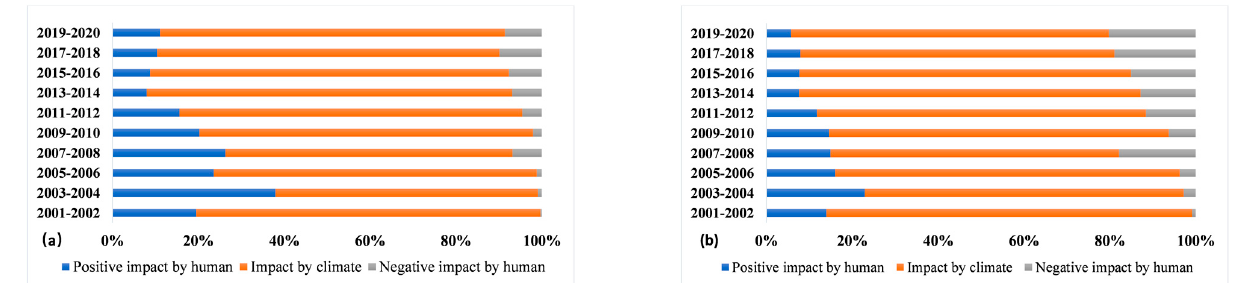
Figure 7. Area percentage of different dominant factors in ( a ) karst areas and ( b ) non-karst areas. Based on the dominant factor analysis, the downside of human activities still outweighed the positive influence on natural vegetation. High-intensity human activities, mainly the unrestrained utilization of land resources, have increased the pressure on vulnerable karst landscapes in the whole basin. Figure 8 shows four cases in karst area, reflecting the damage to natural vegetation caused by diversified human production activities. As illustrated in case(A) and case(B) of Figure 8, the destruction of forests and fragmentation of landscapes were direct consequences of quarry operations, and the NDVI curve manifestations of mining activities sharply decreased; moreover, these mining activities also had negative impacts on regional ecology, such as degradation of ecosystems, deterioration of water quality and biodiversity loss [56–58]. Case(C) shows a large area of artificially grown Eucalyptus. This kind of fast-growing tree has been widely planted in basins with short rotation lengths and strong adaptability, posing a threat to autochthonous species. Additionally, the plantations of Eucalyptus depleted the poor soil in karst regions and hastened regional rocky desertification after logging. As Case(D) indicates, the orchards were reclaimed from native trees on the hillsides. No grass or other plants grew among the parallel rows of fruit trees. Undoubtedly, the cultivation of fruit trees has caused severe ecological and environmental consequences. The utilization of pesticides in fertilizers contaminated the surface soil, and pollutants more easily migrated and diffused on slopes via surface runoff. Furthermore, soil erosion was aggravated, and vegetation coverage sharply decreased with the extensive expansion of orange trees, resulting in the continuous destruction of vegetation landscapes.